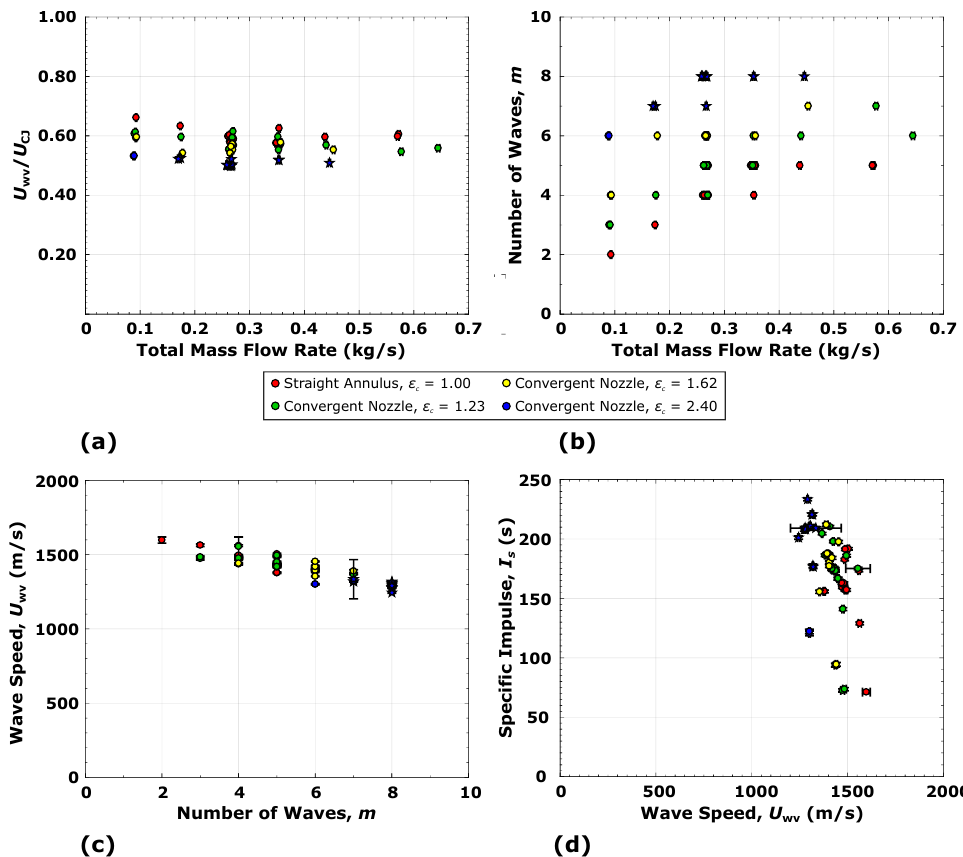
Figure 13. Summary of the detonation mode characteristics for the total mass flow conditions at φ = 1.15, depicting the ( a ) wave speed percentage of ideal and ( b ) number of waves m , as well as the wave speed sensitivity to the ( c ) number of waves and ( d ) specific impulse I s . Depending on the flow condition and convergent nozzle geometry, the engine operates in either a corotating ( • ) or counter-propagating mode ( (cid:63)